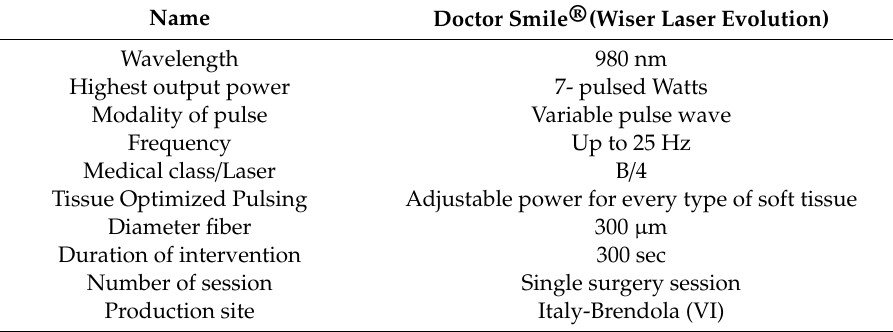
Table 1. Setting of the device.